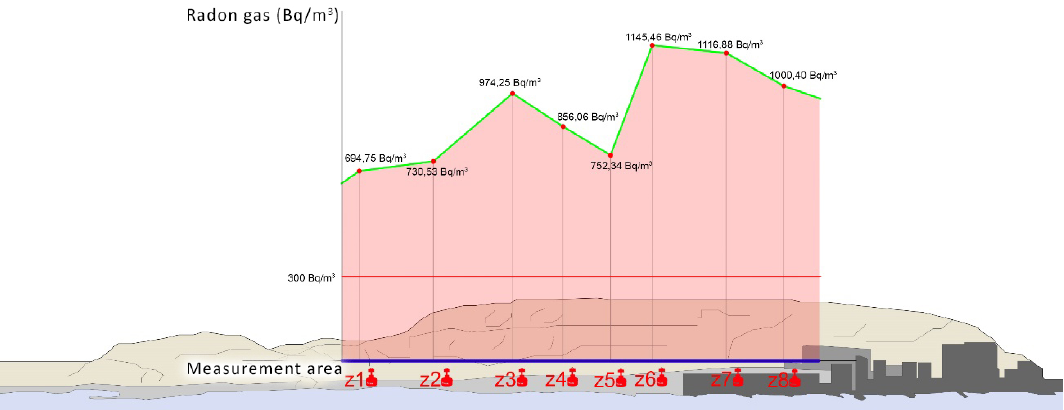
Figure 17. Comparative bar graph of the results obtained in the Serra Grossa tunnel, measured in Bq/m 3 , superimposed on the tunnel